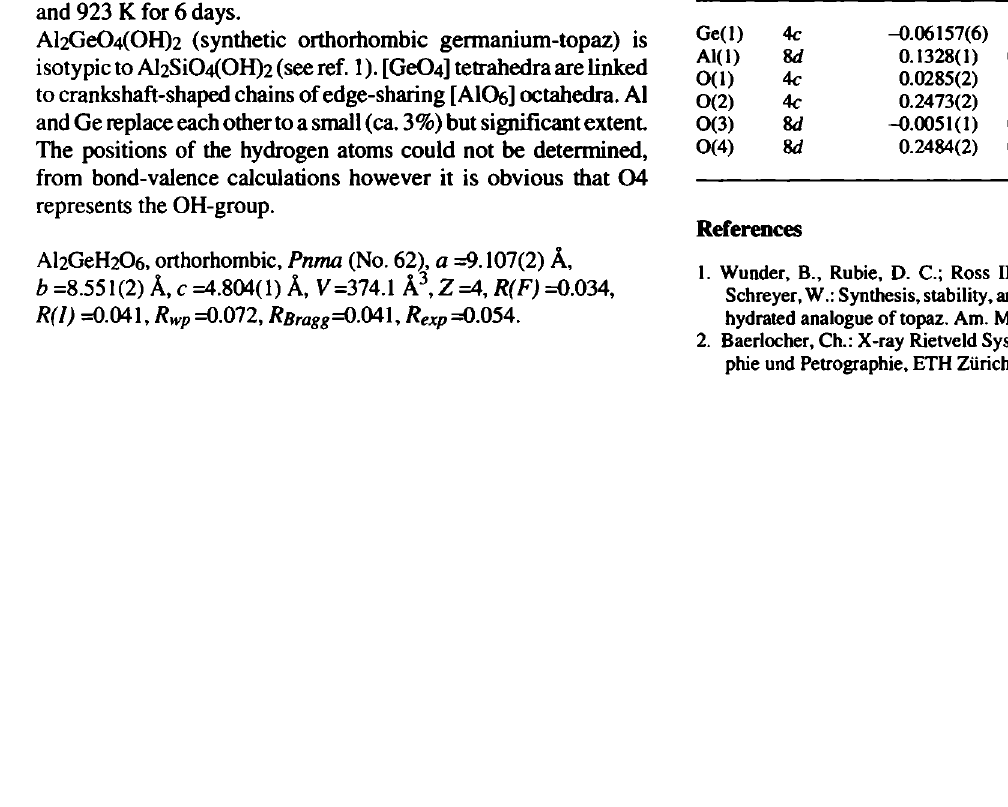
Table 2. Final atomic coordinates and displacement parameters (in